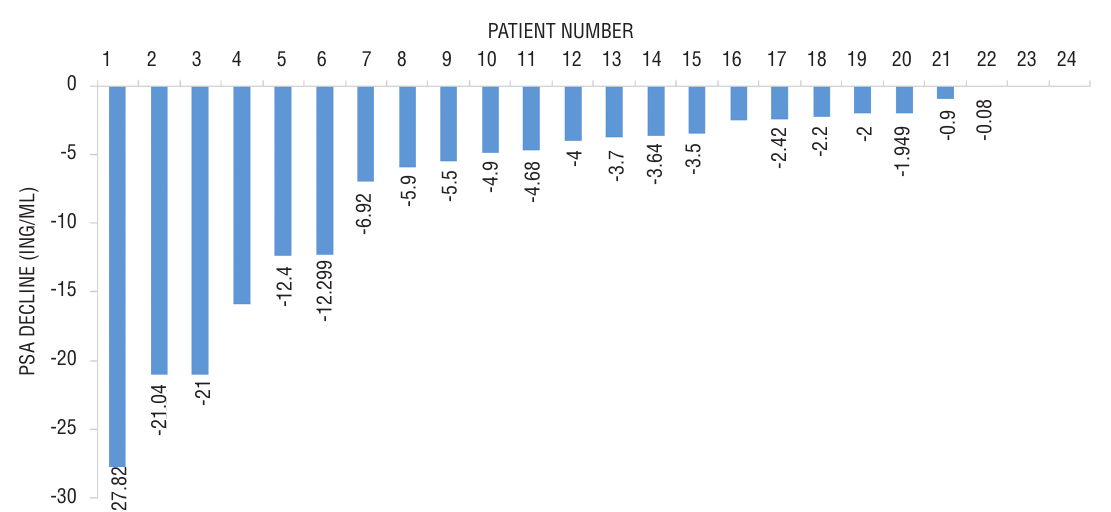
Figure 1 - (A) Maximum PSA decline and (B) Timing of maximum PSA decline (post-HIFU nadir) and timing of PSA failure for individual patients treated with salvage